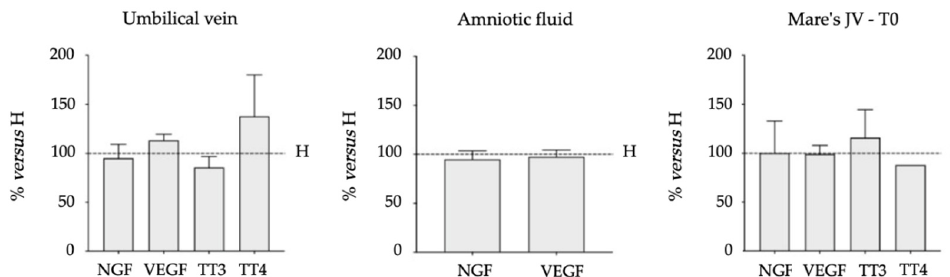
Figure 2. Biomarkers comparison between NE group versus H group. Levels in samples obtained from umbilical cord vein, amniotic fluid and mare’s jugular vein (JV) at parturition (TP) are expressed as percentage of the mean of the results obtained in the healthy group (H) at each time point. No differences were observed between groups. Among the different biological fluids analyzed, no correlation was found in either the NE or exNE group, but in NE group NGF levels were positively correlated with both TT3 ( p = 0.0475; r = 0.3424) and TT4 levels ( p = 0.0063; r = 0.4589), as shown in Figure 3.